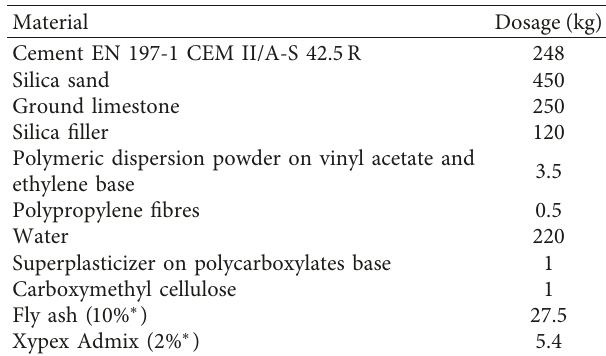
Table 3: Composition of polymer cement screed (SC); ∗ percentual substitute for cement was based on the initial dose 270kg/m 3 of cement.